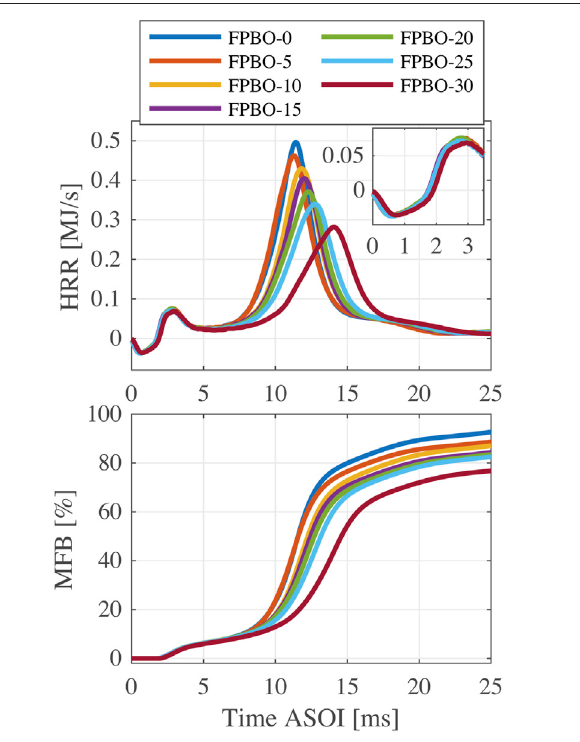
FIGURE 9 | HRR and MFB pro fi les of FPBO and n-butanol blends with FPBO mass fractions of 0% – 30% (5% EHN, T wall = 550 °